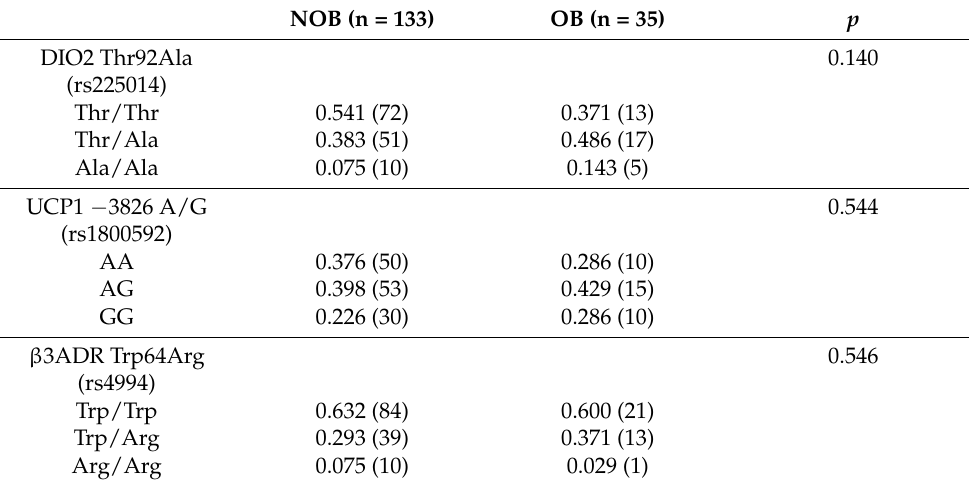
Table 8. Genotype distribution of SNPs in